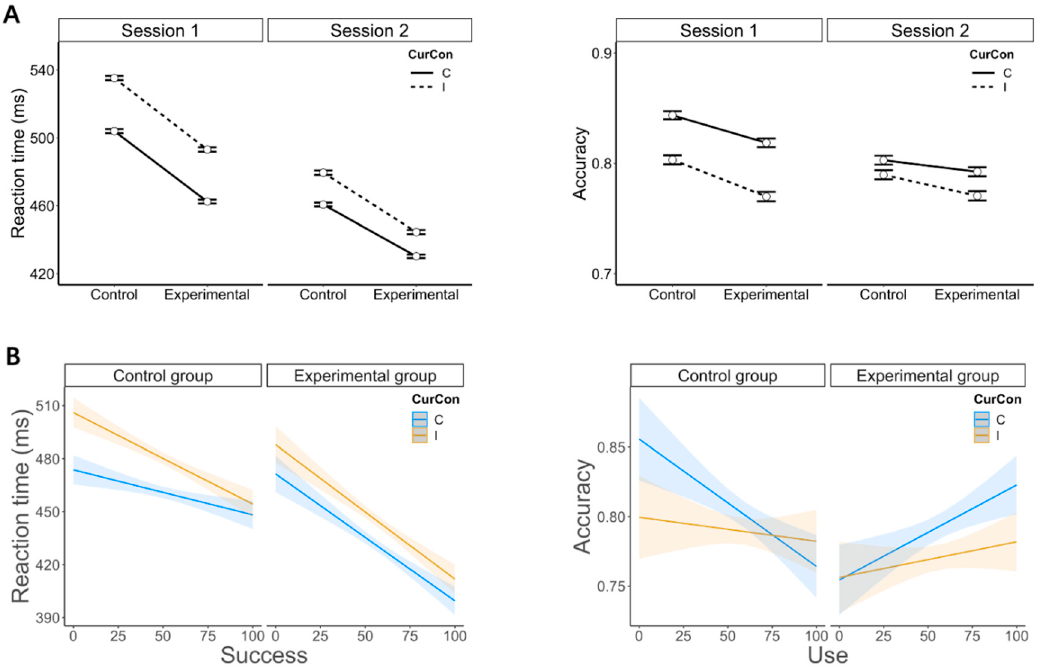
Figure 3. Behavioral results. ( A ) Conflict processing for the standard analysis (experimental group vs. control group). Conflict processing was similar in the two groups for RTs (left panel) and accuracy (right panel). ( B ) The influence of emotion regulation on conflict processing was modulated by the self-reported scores of emotion regulation. In the experimental group, conflict processing was not modulated by the perceived success of emotion regulation. However, in the control group, the conflict effect was reduced when the perceived success of emotion regulation increased. This effect could not be explained by a speed–accuracy tradeoff as the same trend was visible for RTs (left panel) and accuracy (right panel). Vertical bars correspond to standard errors of the mean.